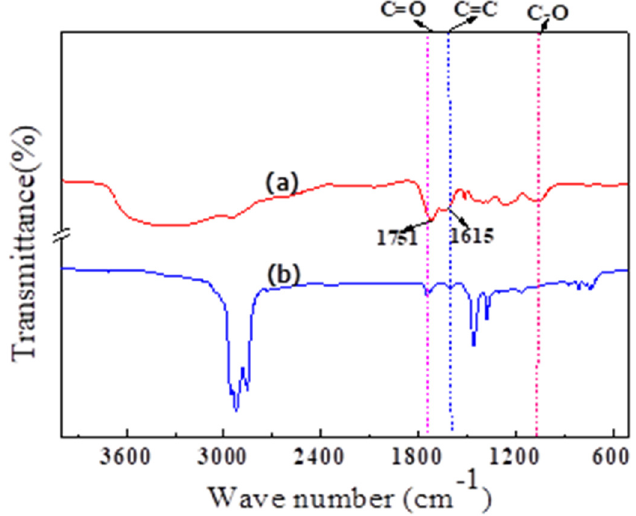
Figure 8. FT-IR analysis of biomass crude oil and emulsified biomass fuel: ( a ) biomass crude oil, ( b ) emulsified biomass fuel.